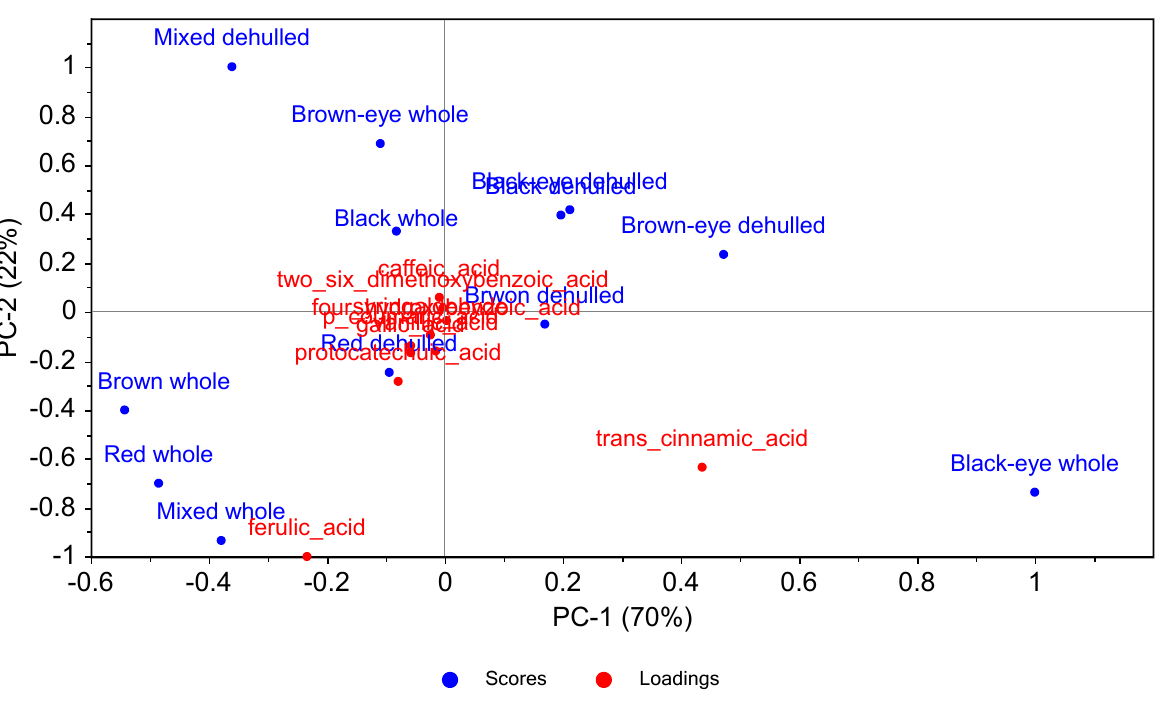
Figure 1. Principal component scores and loadings based on Bambara groundnut form and variety with regard to flavonoids and lignan composition/characterization.